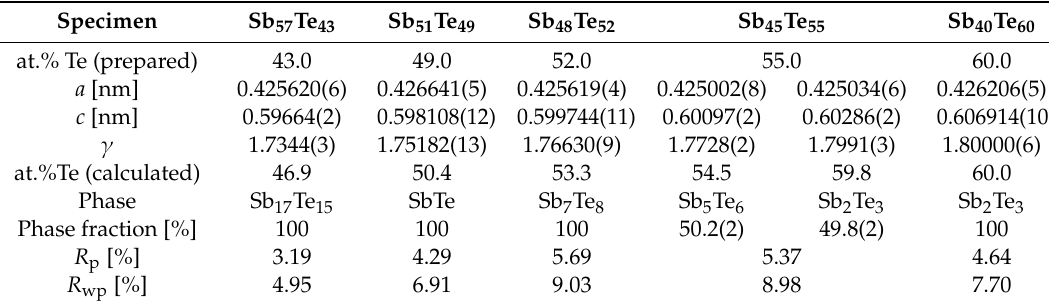
Figure 3. X-ray powder diffraction profiles of Sb–Te specimens acquired at 90 K. The horizontal axis has been enlarged and the intensities are plotted on a logarithmic scale to emphasize the weaker peaks. The arrows indicate peak splitting due to phase separation: A and B correspond to reflections from the Sb 2 Te 3 and Sb 5 Te 6 phases, respectively. Table 1. Refined lattice parameters and final R factors for Sb–Te. The diffraction data used for the analysis were acquired over the 2 θ range of 1.8° to 50.0°.